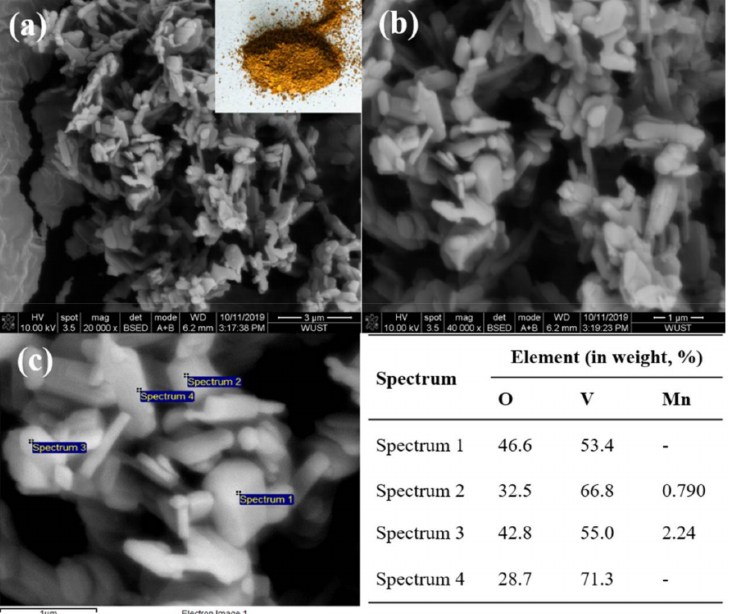
Figure 20. SEM-EDS of the vanadium pentoxide powder, ( a ) magnification × 20,000, ( b ) magnification × 40,000, ( c ) magnification ×